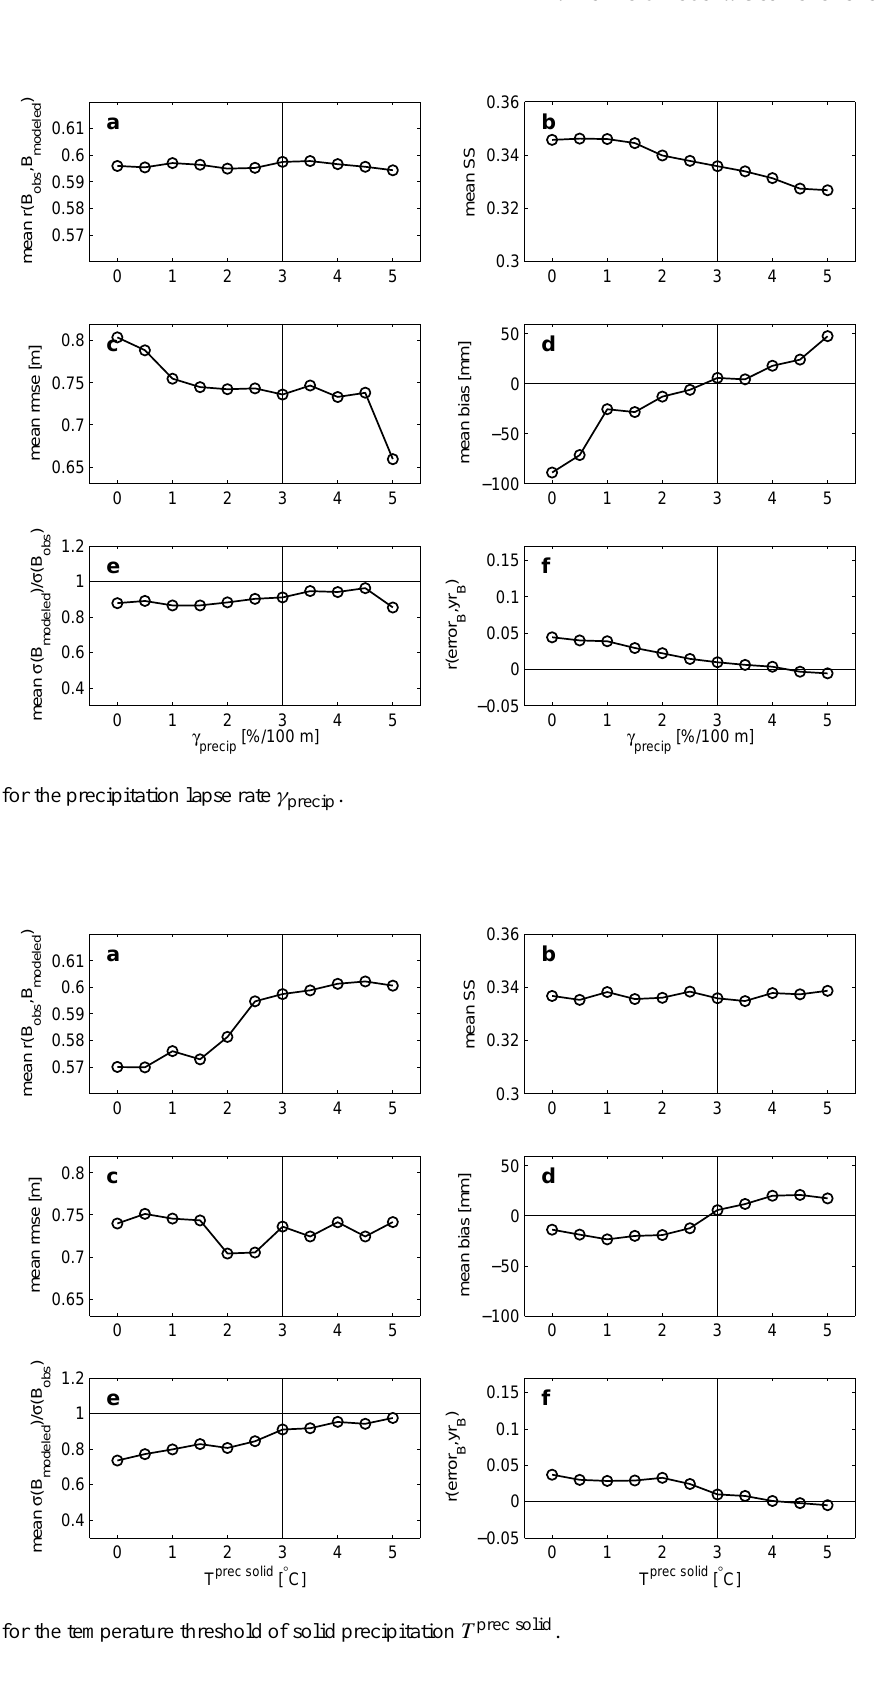
The Cryosphere, 6, 1295–1322,